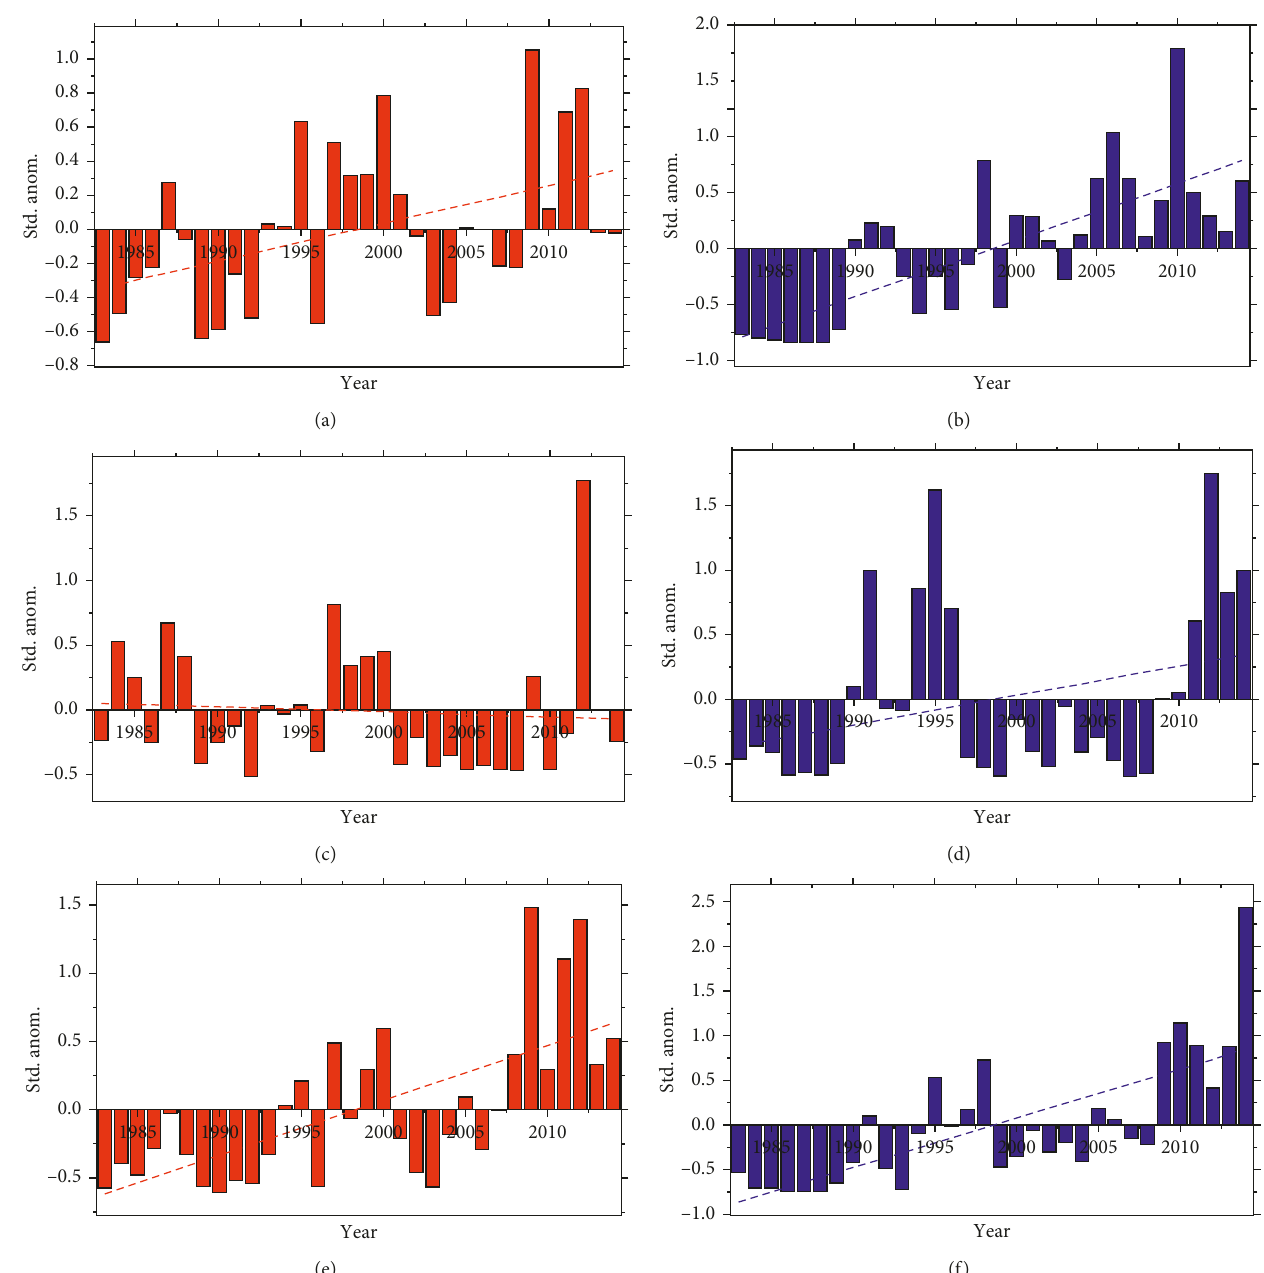
F IGURE 2: Standardized anomalies of warm days (TX90p) over three agroecological zones, (a) lowland, (c) midland, and (e) highland, and for warm nights (TN90p), (b) lowland, (d) midland, and (f) highland, for the period